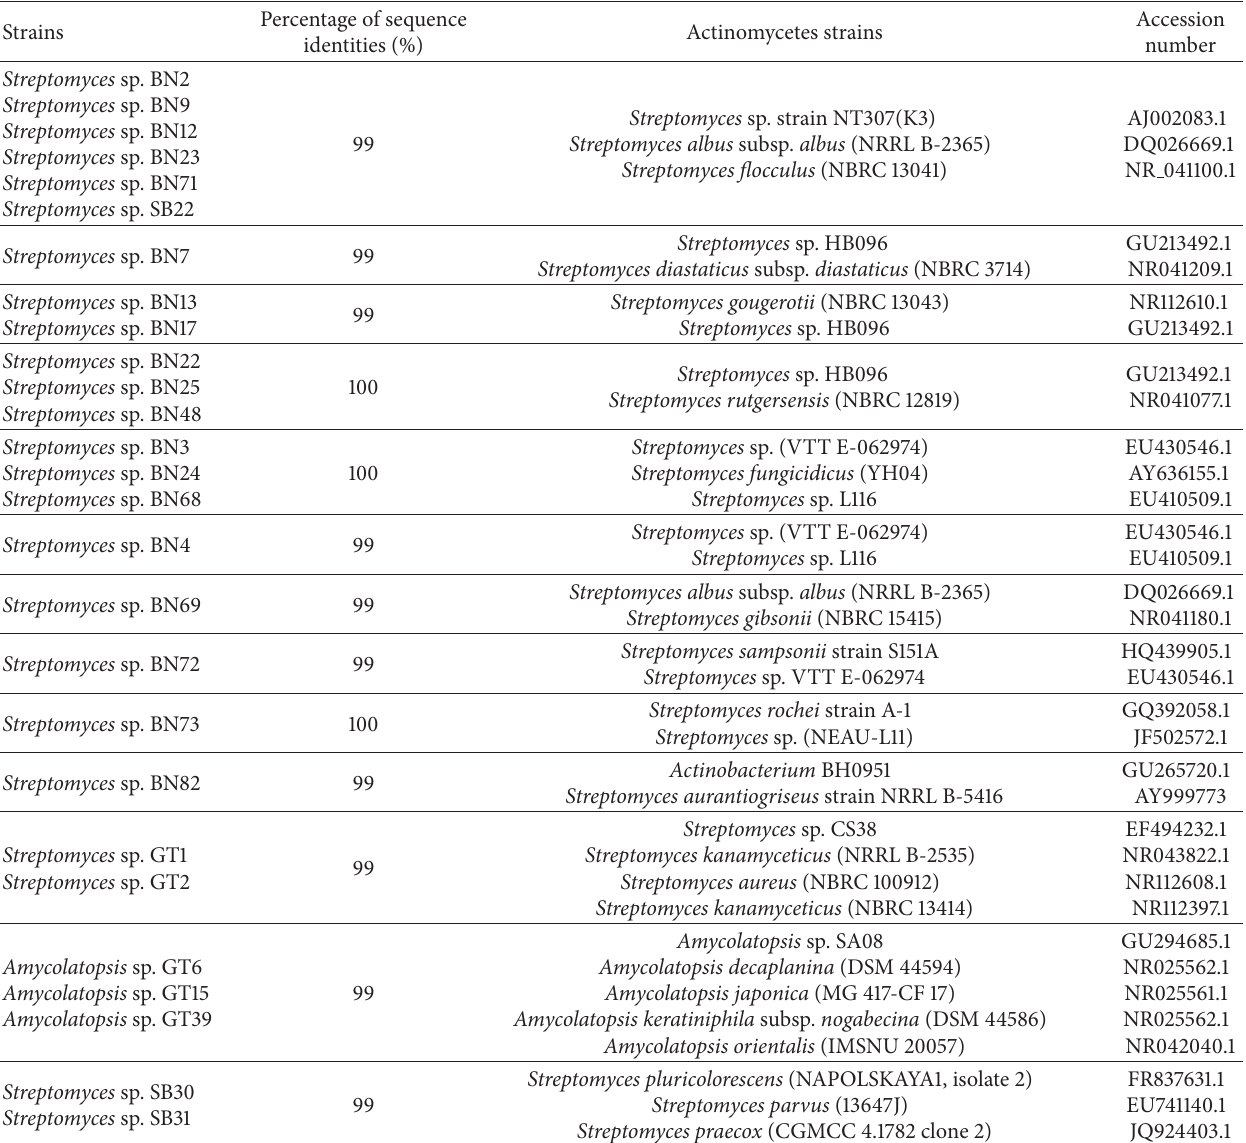
Table 5: Comparison of percent similarities between our 16S rRNA gene sequence and sequences present in the genomic database banks using NCBI BLAST.